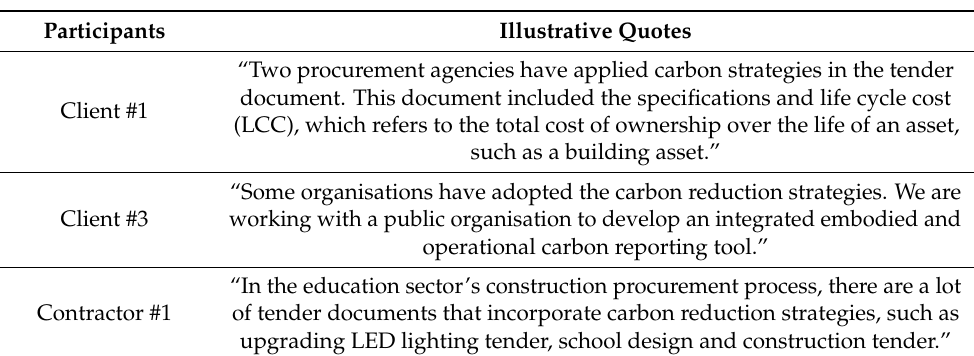
Table 2. The perceptions of research participants regarding the current implementation of carbon reduction strategies in construction